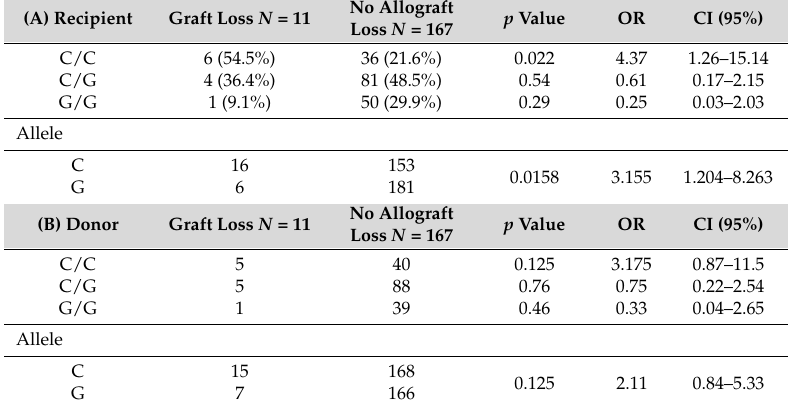
Table 2. The genotype distribution and allele frequencies of the +3142 C>G (rs1063320) gene polymorphism in living-donor kidney transplant recipients ( A ) and the corresponding donors; ( B ) with respect to allograft loss.